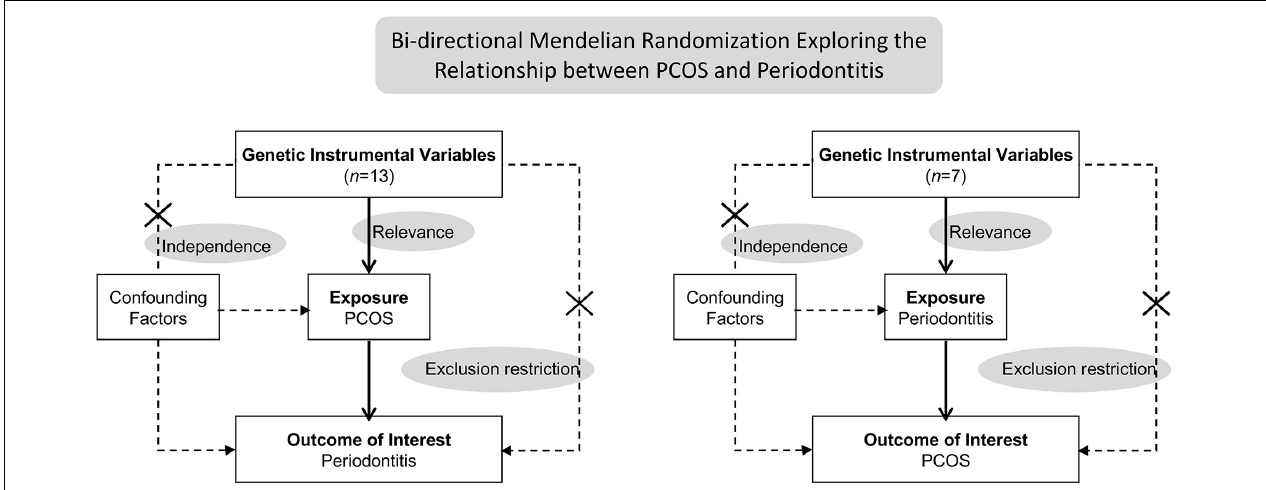
FIGURE 1 | Schematics for the bidirectional Mendelian randomization design. Mendelian randomization requires valid genetic instrumental variants satisfying three assumptions. PCOS, polycystic ovary syndrome.